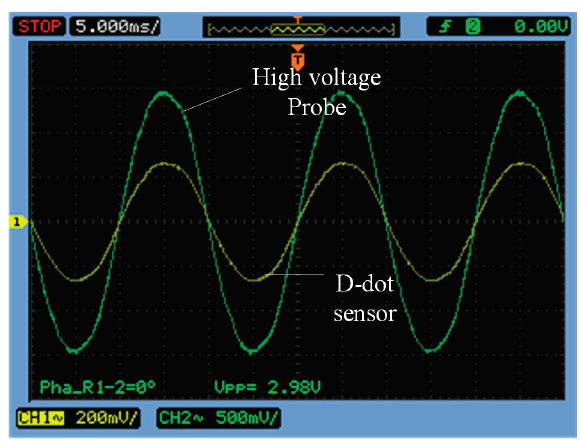
Figure 9. Waveform comparison chart in the 30% of rated voltage.